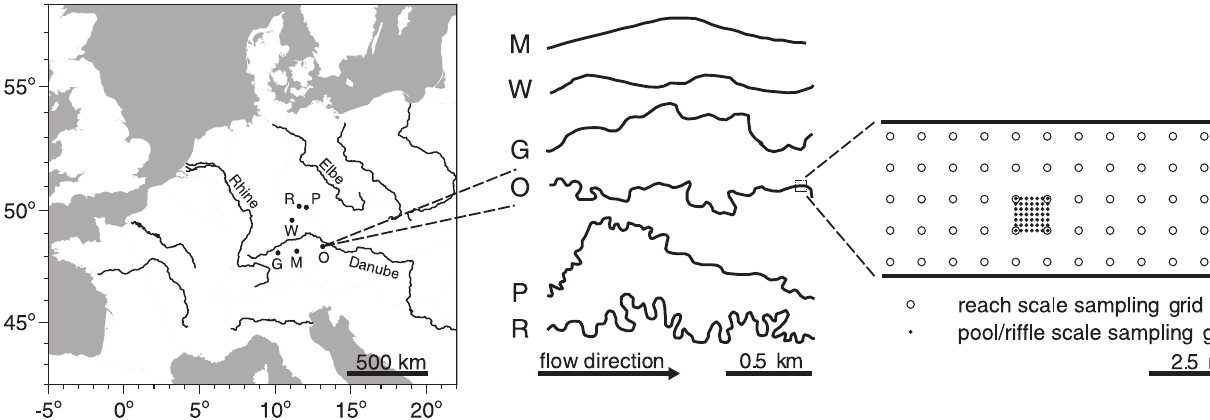
Figure 1. Map and sampling design of the investigated stream reaches. Map of Central Europe comprising the locations of the investigated stream reaches (left panel), their plan view morphologies 2 km upstream of the sampled reach (middle) and a scheme of the nested sampling design (right panel). Open symbols in the right panel denote the reach scale grid (distances of 1 m), closed symbols denote the pool/riffle scale grid (distances of approx. 17 cm). Codes for the stream reaches are M = Moosach, W = Wiesent, G = Guenz, O = Grosse Ohe, P = Perlenbach, R = Suedliche Regnitz.